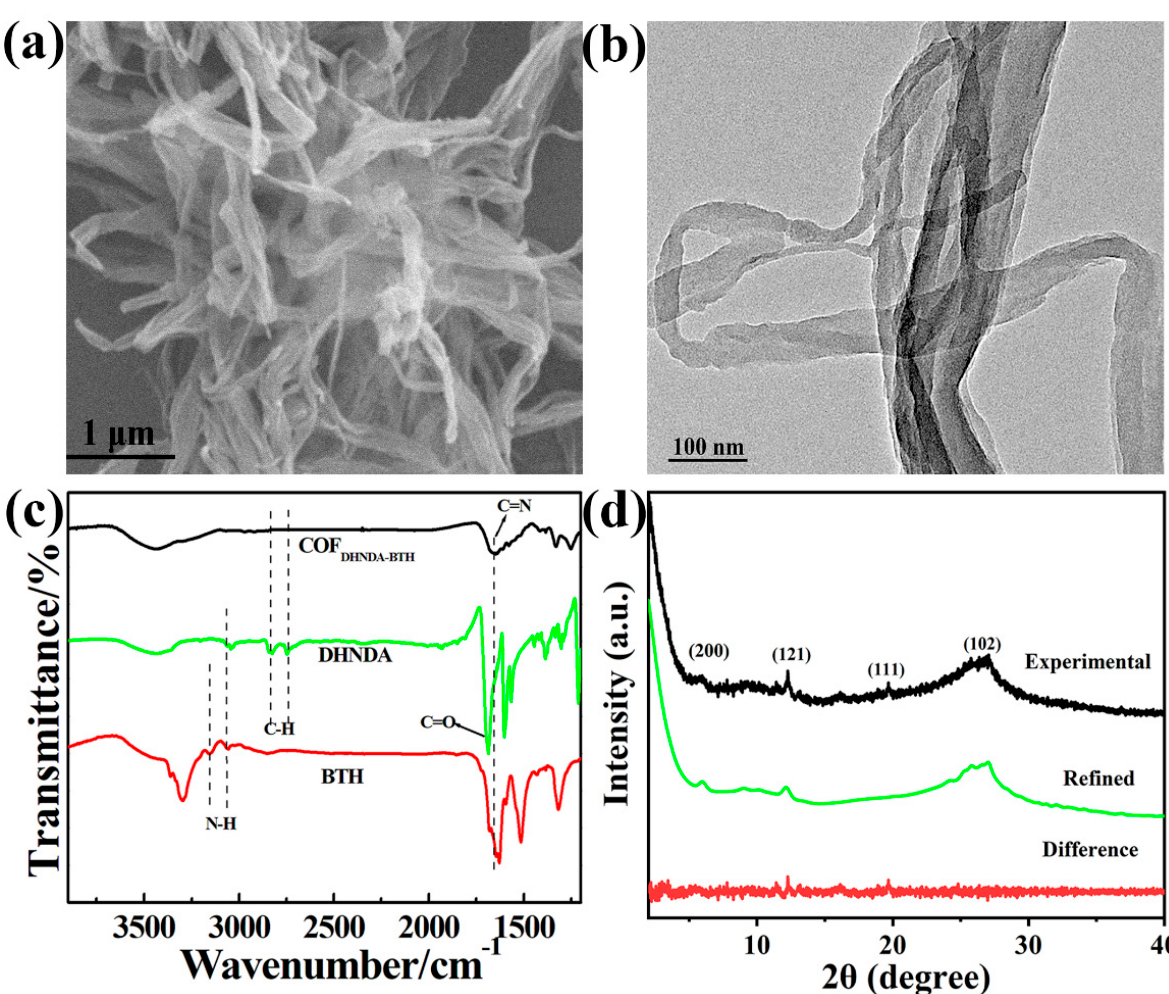
Figure 1. ( a ) SEM image of COF DHNDA-BTH . ( b ) TEM image of COF DHNDA-BTH . ( c ) FTIR spectra of DHNDA, BTH, and COF DHNDA-BTH . ( d ) Experimental and refined XRD pattern as well as the difference.